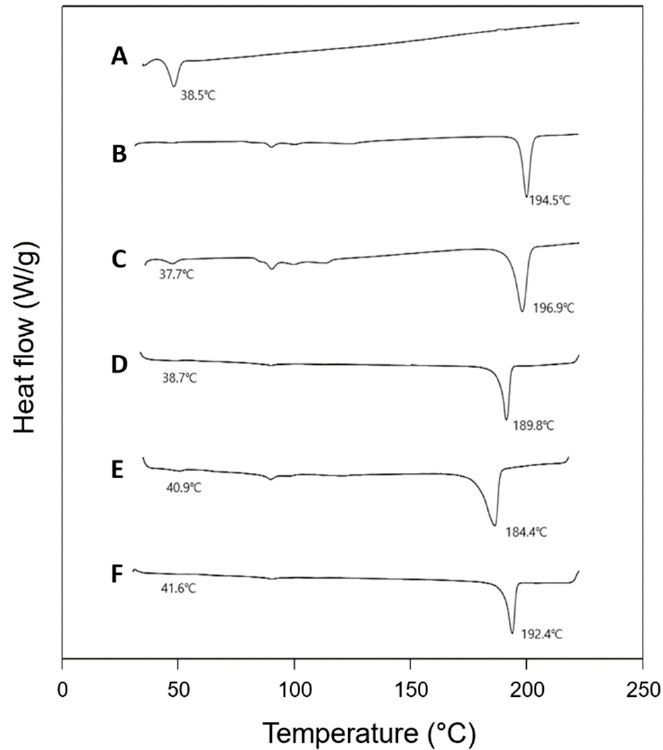
Figure 3. Differential scanning calorimetry (DSC) thermograms of ( A ) PLGA RG 502; ( B ) rivoceranib; ( C ) physical mixture (1:1) of PLGA RG502 and rivoceranib; ( D ) PLGA RG502 and rivoceranib (1:1) blend film; ( E ) PLGA RG502H and rivoceranib (1:1) blend film; ( F ) PLGA RG503H and rivoceranib (1:1) blend film. The downward peaks in the diagrams represent the endothermic behavior.